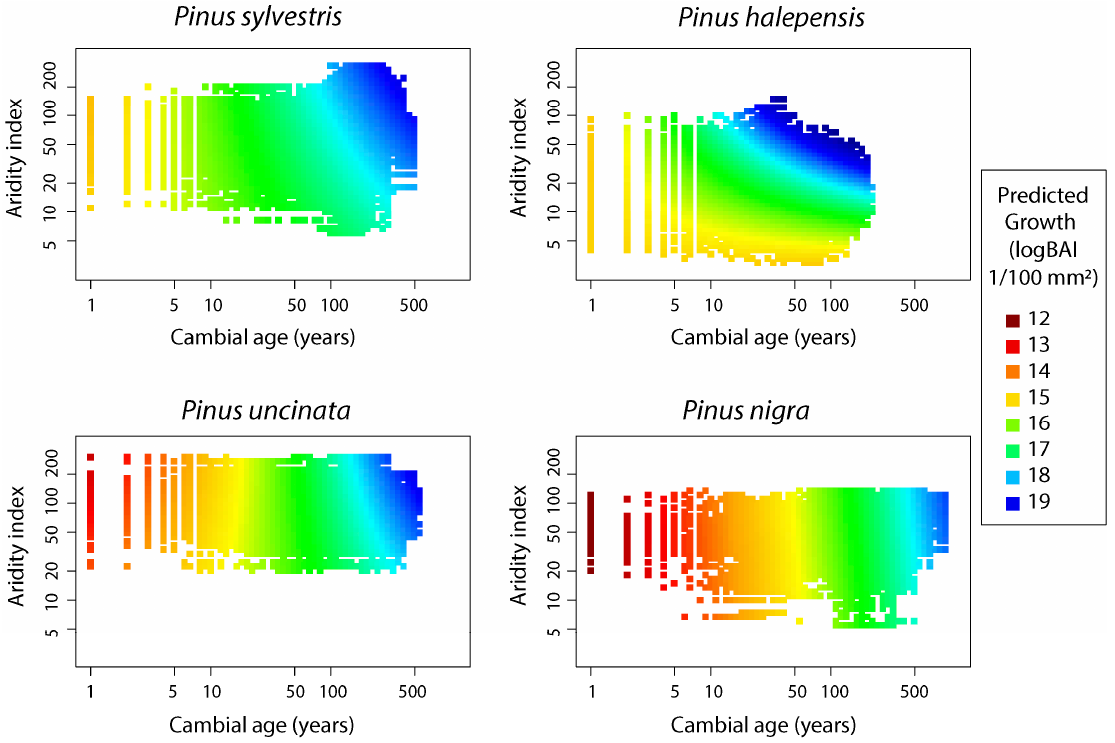
Figure 5. Predicted growth (in log BAI 1/100 mm 2 ) over different climate conditions and tree ages where the species are present.